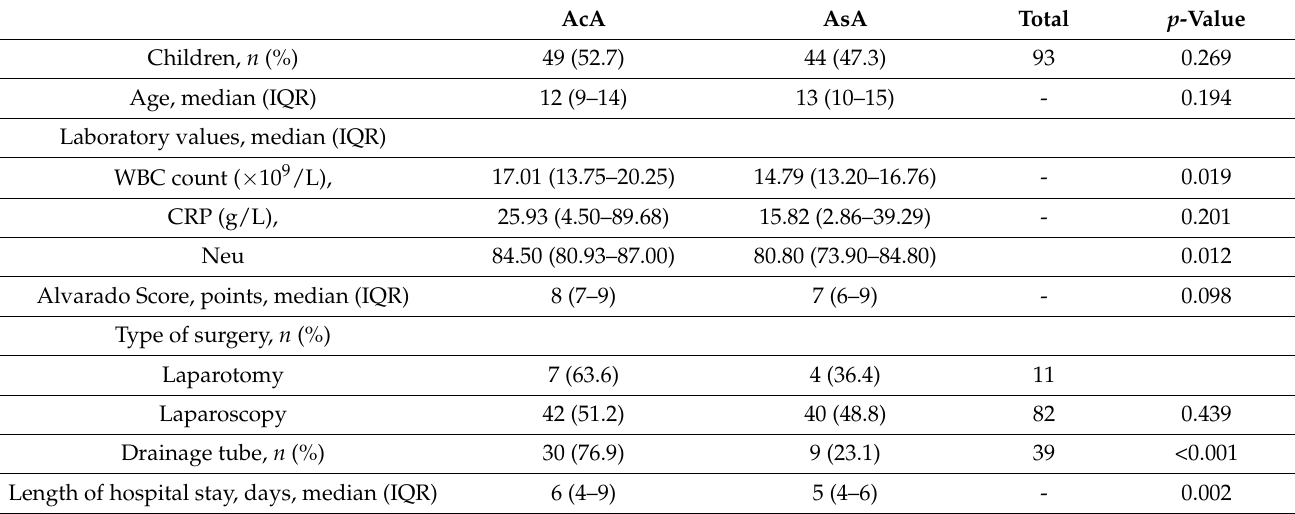
Table 1. Overview of study population.